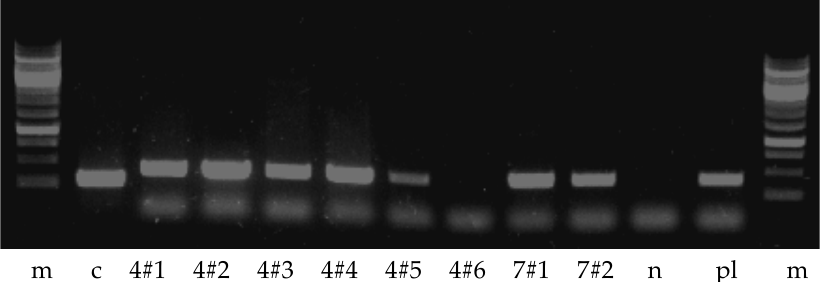
Figure 2. Selection of hairy roots performed via the PCR method. The 423 bp fragment of the rolB